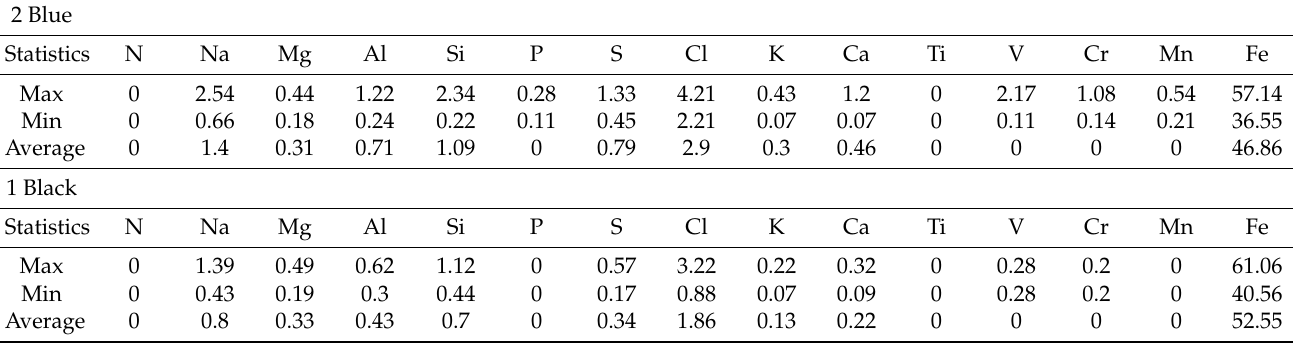
Table A1. EDS table percentage weight of